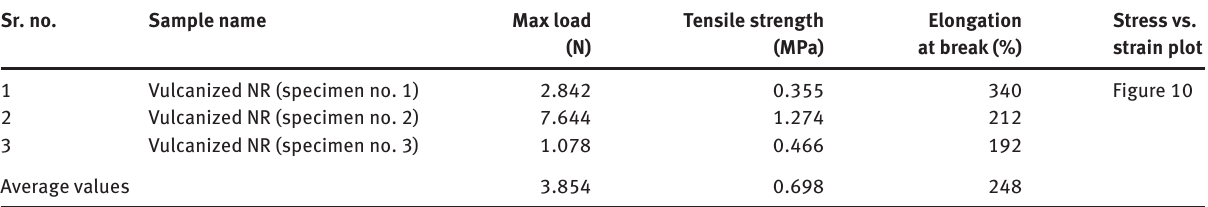
Table 8: Mechanical properties of vulcanized NR after heat resistance at 80 ° C for 4 h. Sr.